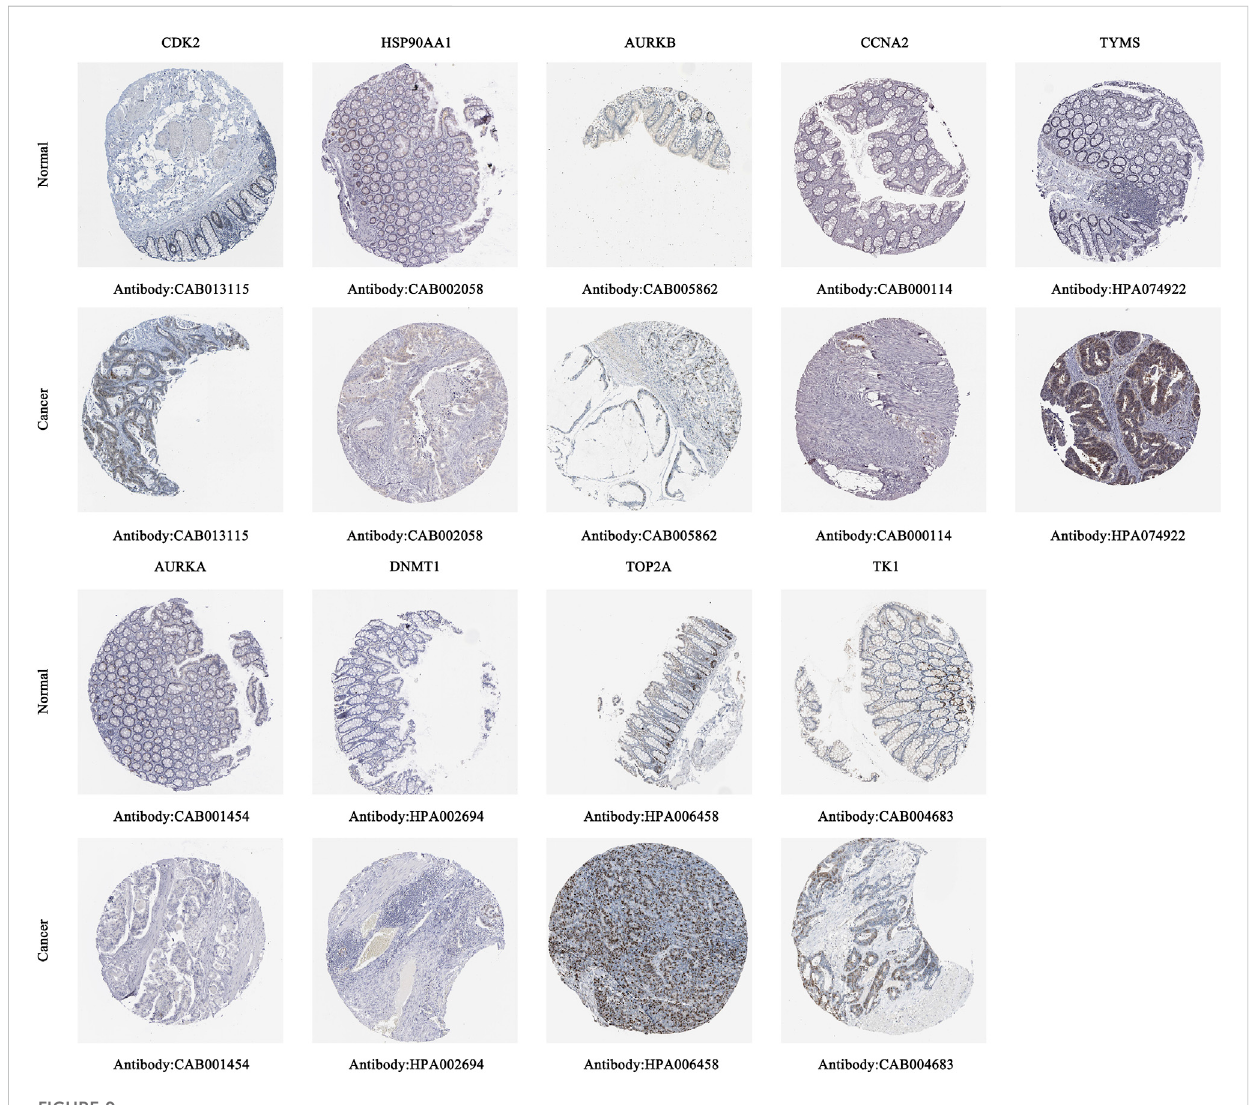
FIGURE 9 Immunohistochemical images of hub gene protein expression levels in the HPA